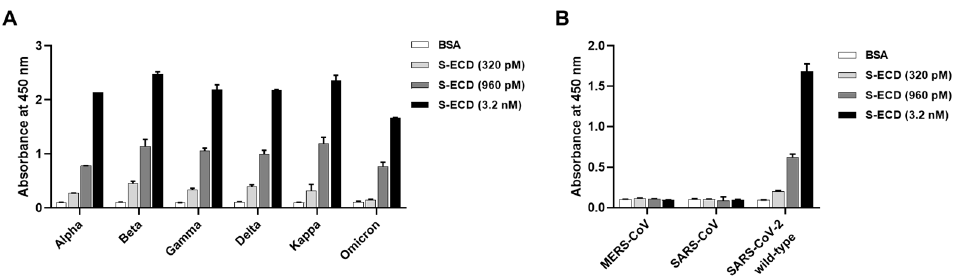
Figure 5. Detection of the spike proteins of wild-type MERS-CoV, SARS-CoV, and SARS-CoV-2 and variants using the developed sandwich immunoassay. Detection efficiency of the established sandwich immunoassay was evaluated in the absence (using negative control BSA) and presence of increasing concentrations of the spike proteins of ( A ) SARS-CoV-2 variants (Alpha, Beta, Gamma, Delta, Kappa, and Omicron) or ( B ) wild-type MERS-CoV, SARS-CoV, and SARS-CoV-2. All values represent mean ± SD of triplicate measurements from one out of two independent experiments.